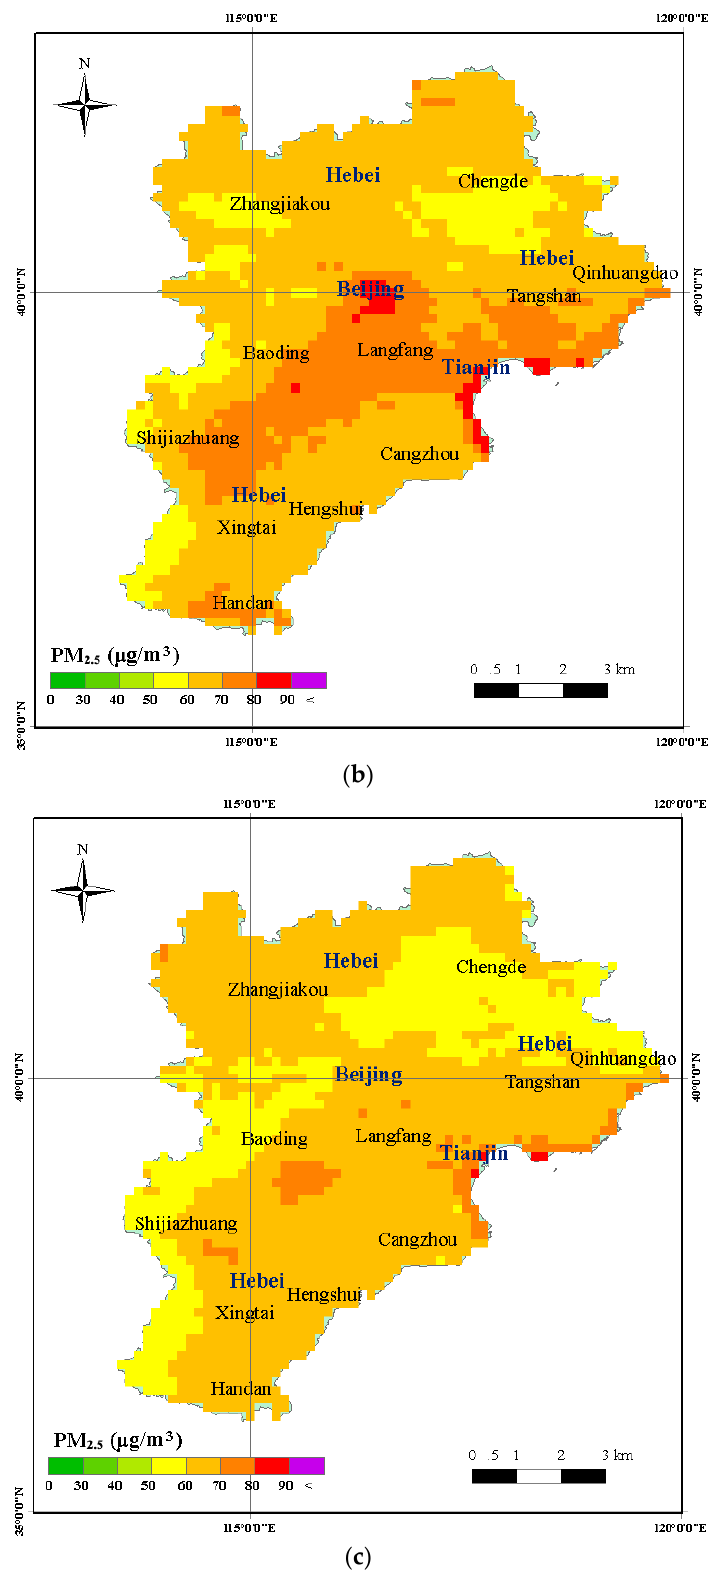
Figure 5. The spatial distribution of the annual mean PM 2.5 concentration in the Beijing-Tianjin-Hebei (BTH) region. ( a ) Annual mean PM 2.5 concentration in 2014; ( b ) Annual mean PM 2.5 concentration in 2015; ( c ) Annual mean PM 2.5 concentration in 2016.